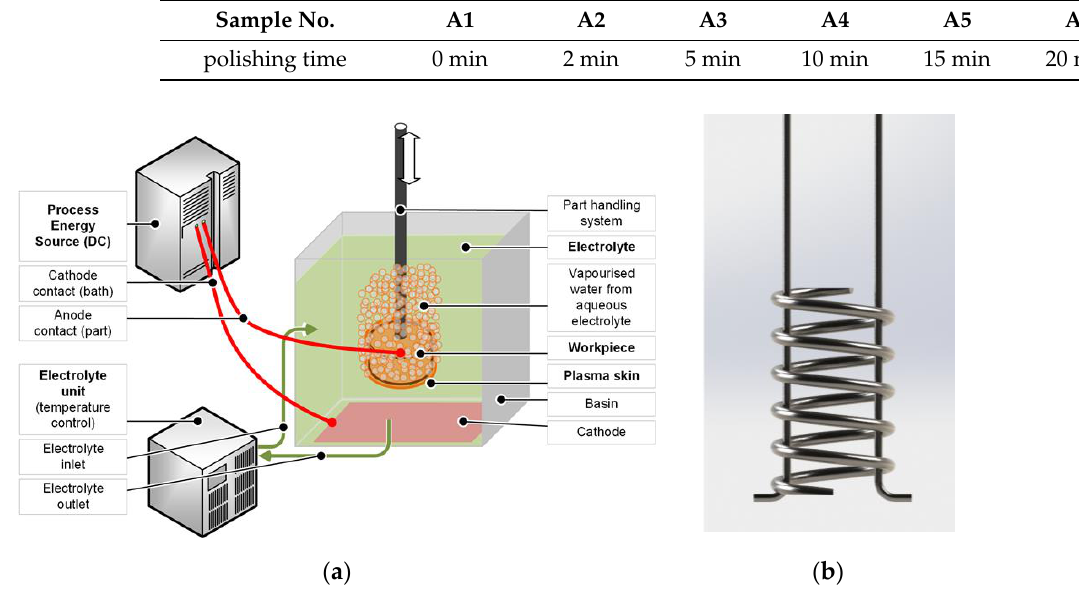
Table 2. Overview of PeP treatment times for each sample.